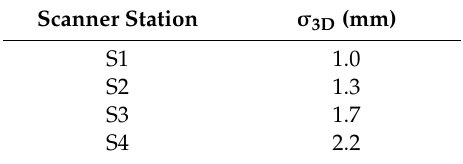
Table 1. Standard deviation of the registration on TLS scanner